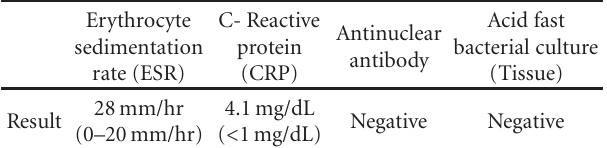
Table 2: Relevant laboratory